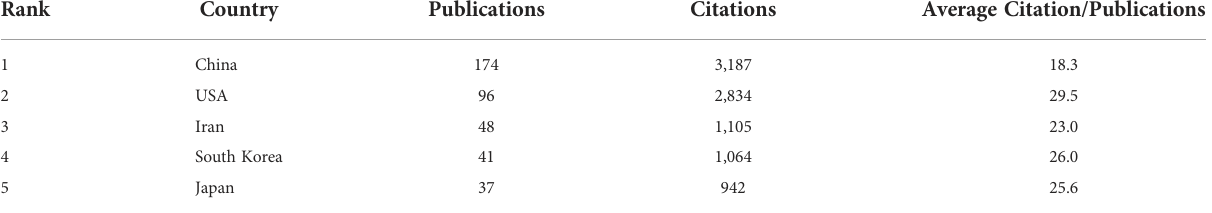
TABLE 1 The publications and citations of Top 5